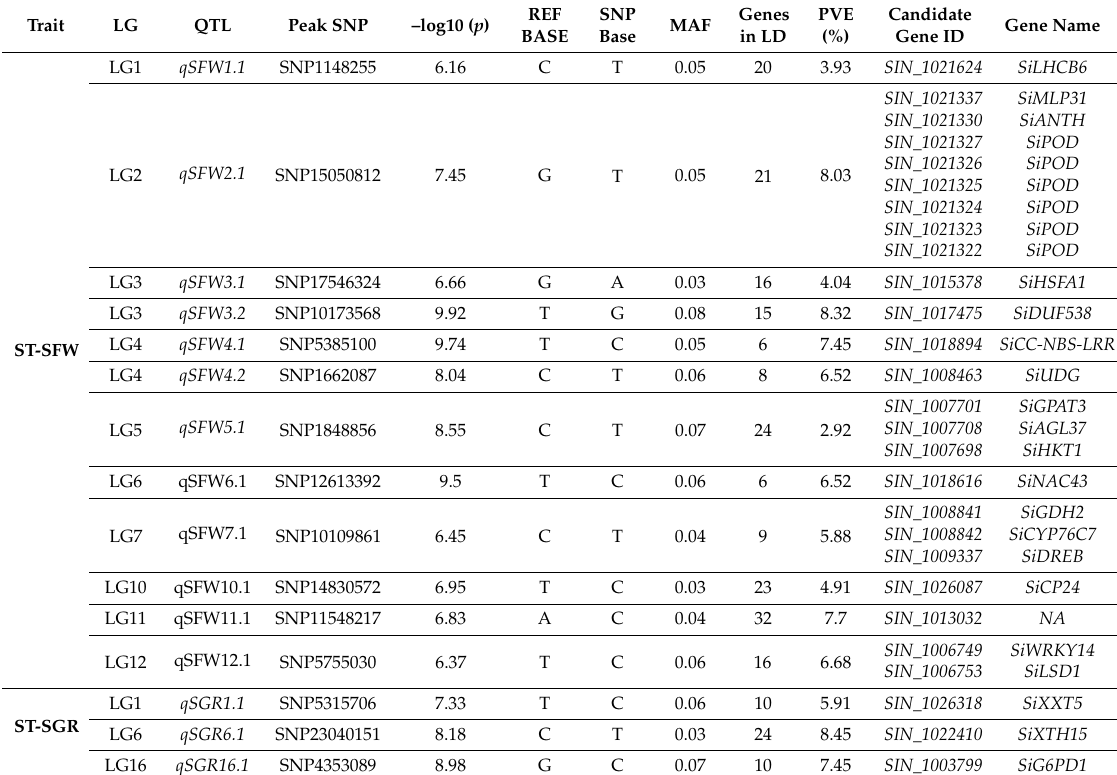
Table 4. SNPs significantly associated with NaCl-induced salt tolerance indexes at the germination stage in